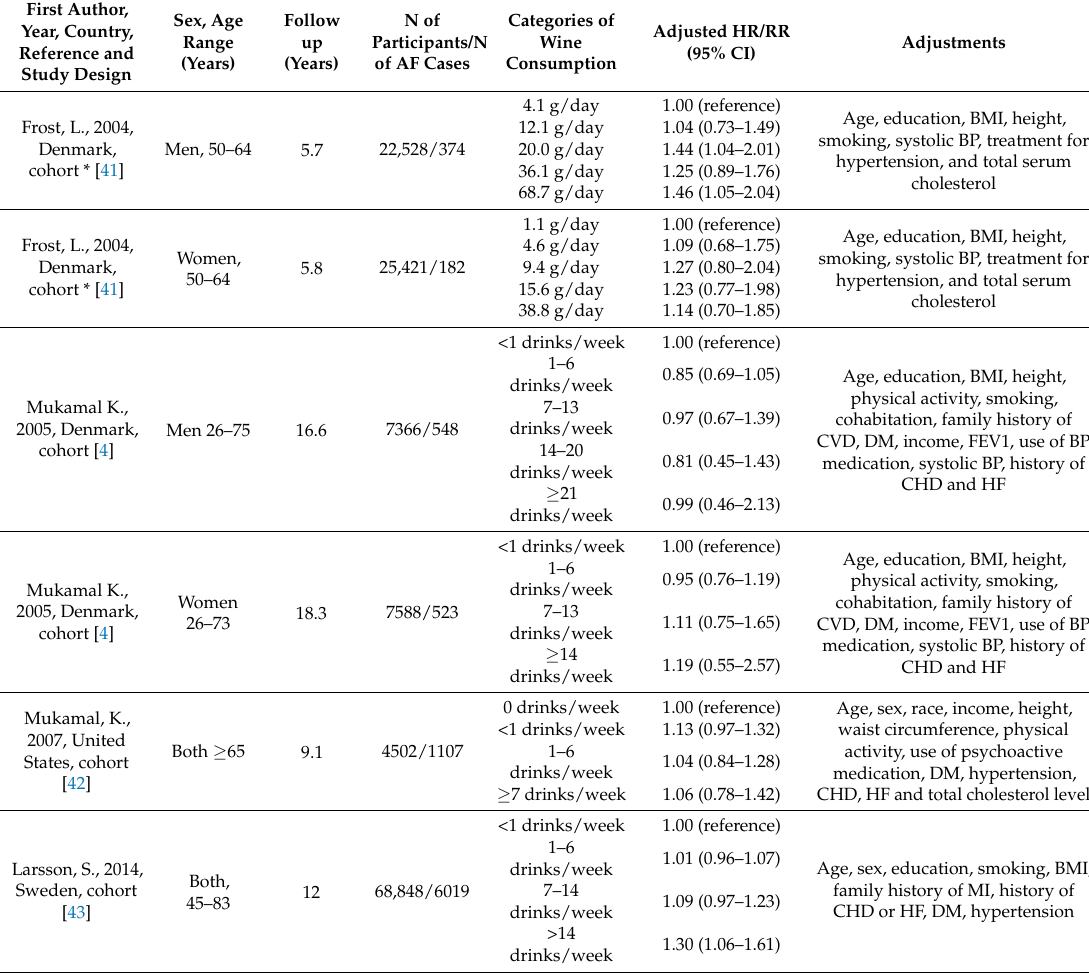
Table 1. Characteristics of Prospective Studies of Wine Consumption and Risk of Atrial